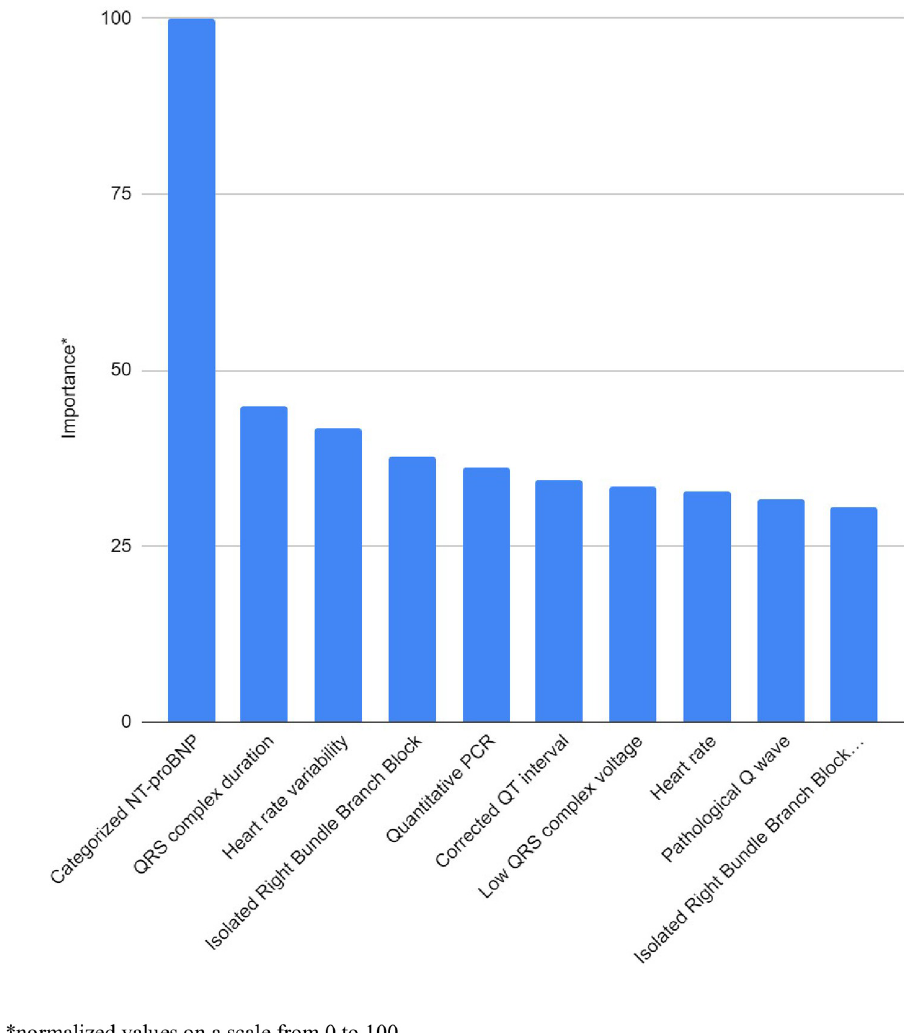
Fig 4. Importance of predictor variables of complementary exams for predicting death in patients with CD, within two years, according to Random Forests ranking.